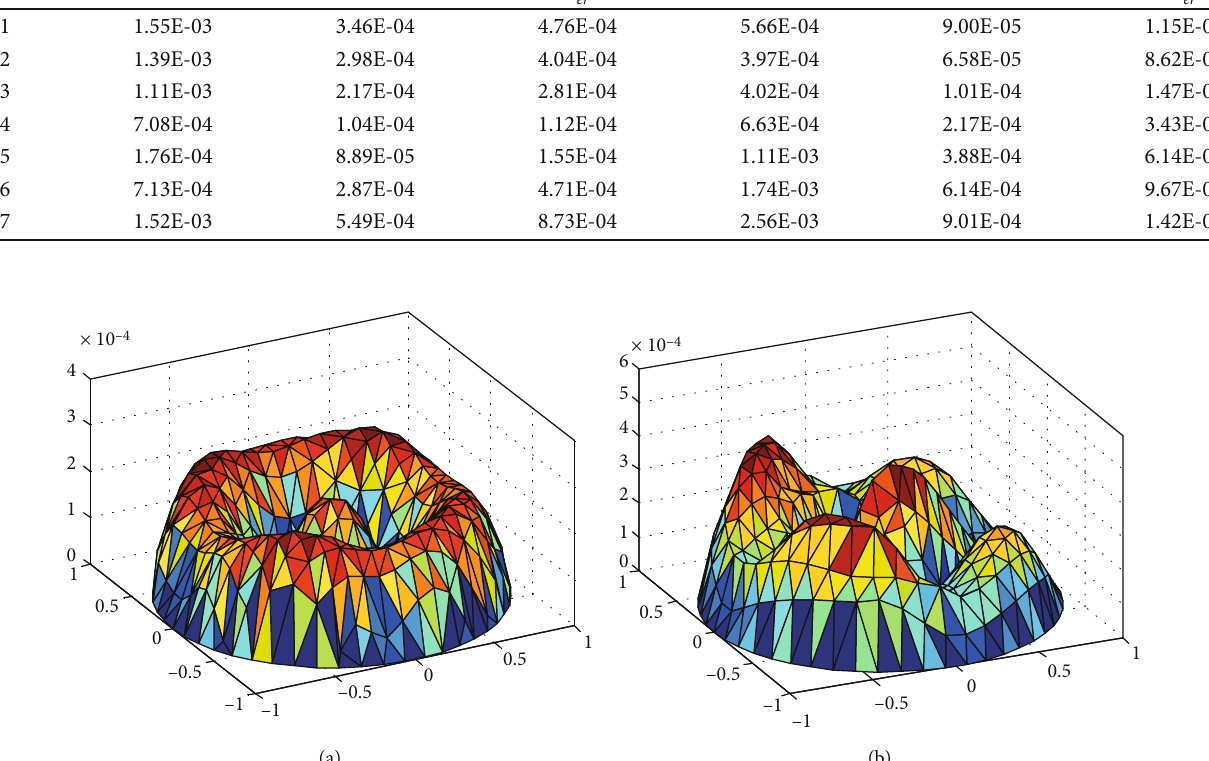
= 10 . Uniform (a) and circular (b). Example 2 with Dirichlet t